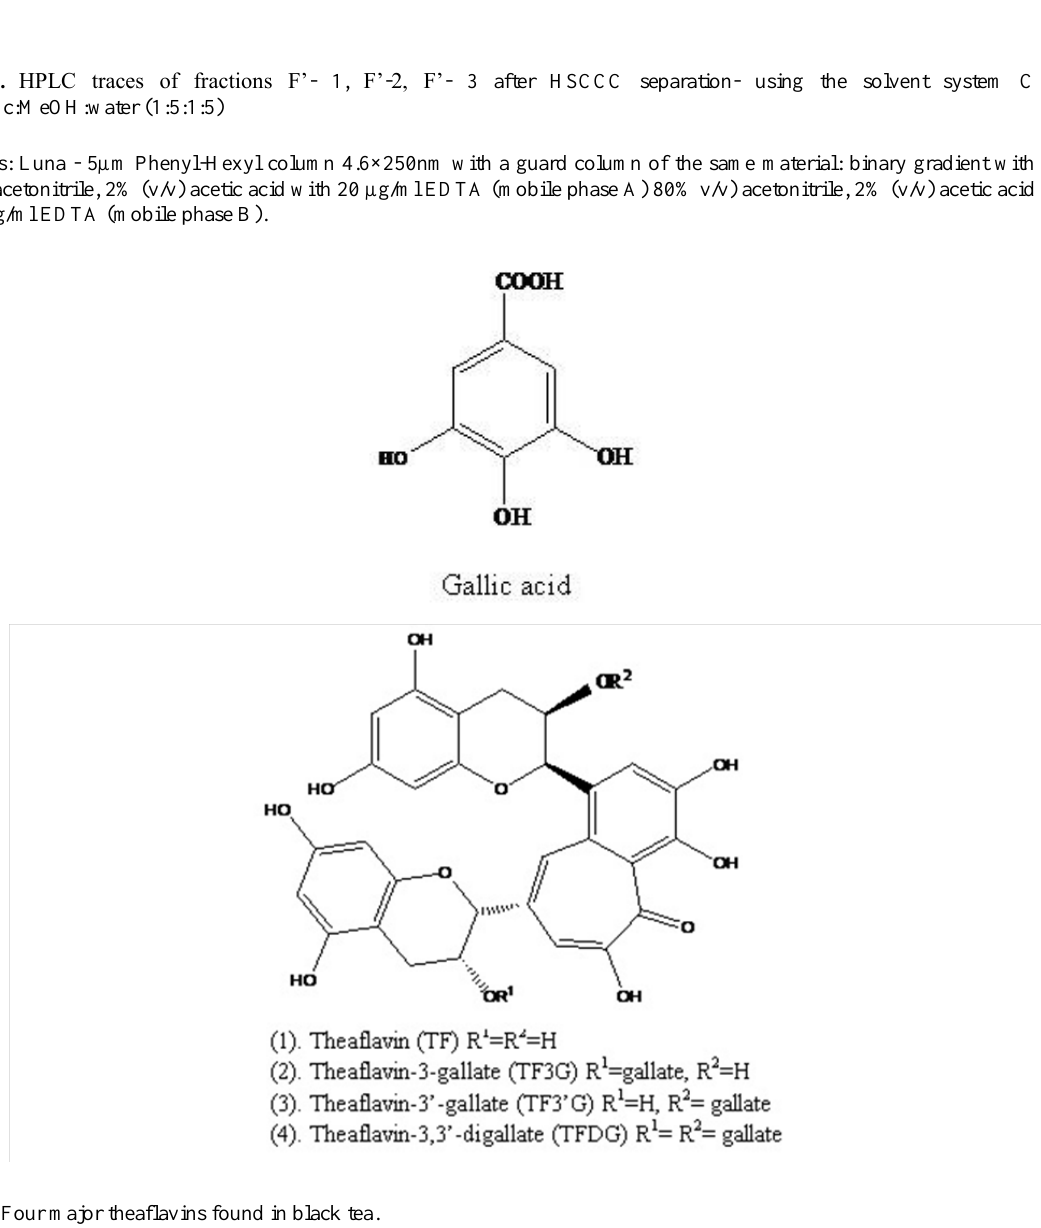
Figure 5: Four major theaflavins found in black